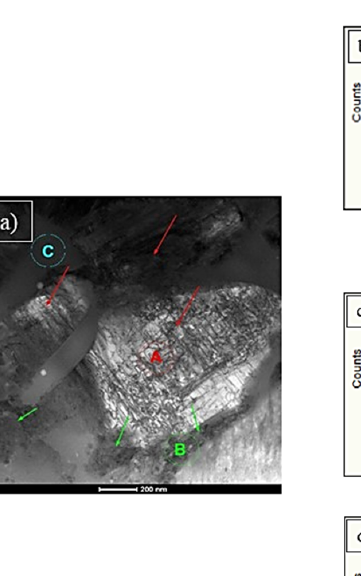
Figure 9. SAED diffraction analysis of sample C1; for the area marked on Figure 8a with letter A: